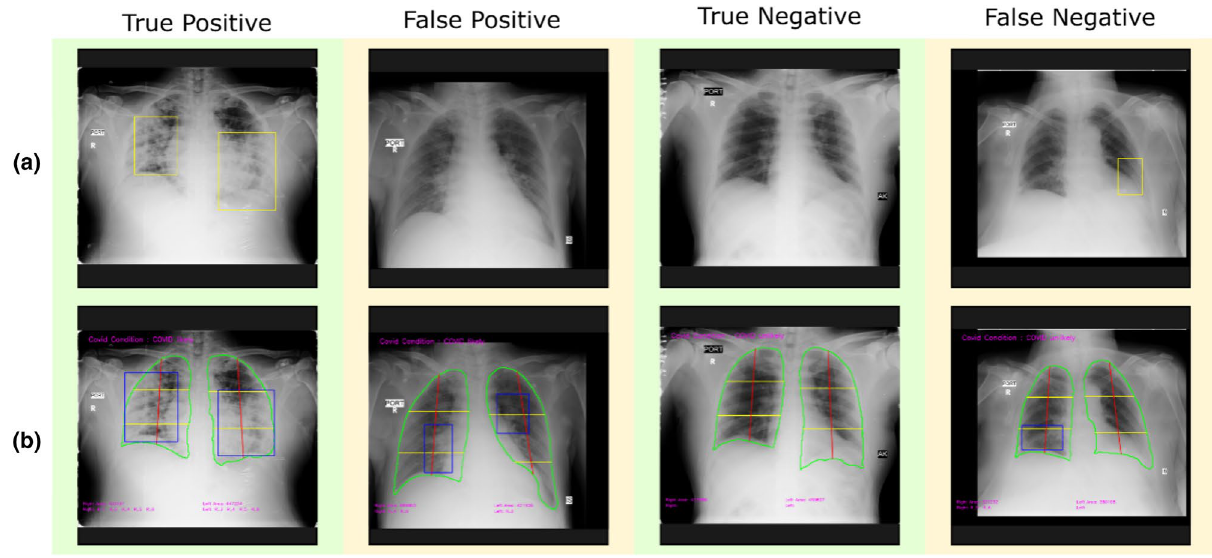
Figure 5. Samples of true positive, false positive, true negative, and false negative from independent validation set of 905 CxRs ( a ) Ground truth CxR ( b ) CovBaseAI inferencing result.